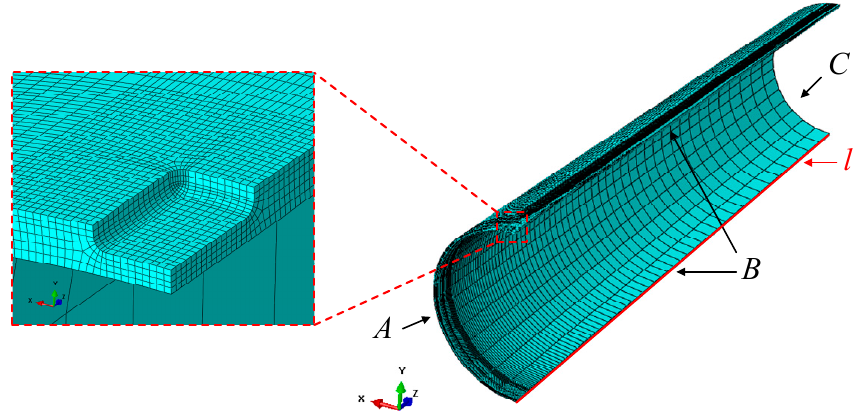
Figure 12. Boundary condition and mesh generation.